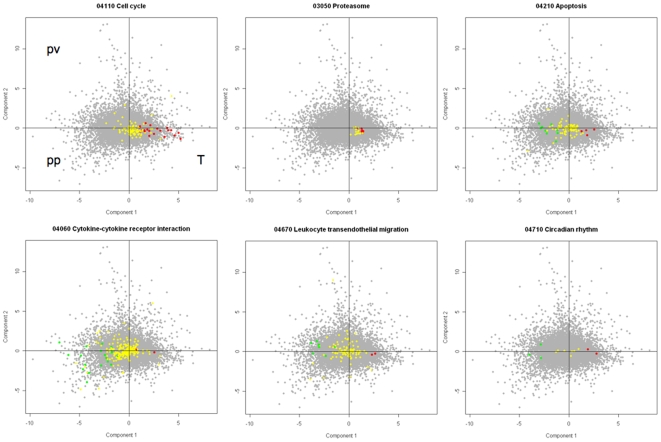
Selected pathways with distribution of differentially expressed genes (P<0.05).This graph depicts the areas of differentially expressed genes in tumour (T), parietal pleura (PP) and visceral pleura (PV). Each dot represents a gene, where red represent genes overexpressed in tumour and green represent genes overexpressed in parietal pleura or visceral pleura. Gray represents all the genes of the chip and yellow represents the genes non-differentially expressed in each pathway. Genes associated to the cell cycle and the proteasome are uniformly overexpressed. More genes associated to apoptosis are downregulated than overexpressed and most genes involved in cytokine-cytokine receptor interaction are down-regulated. Important circadian rhythm genes are differentially regulated (see Fig. 8).